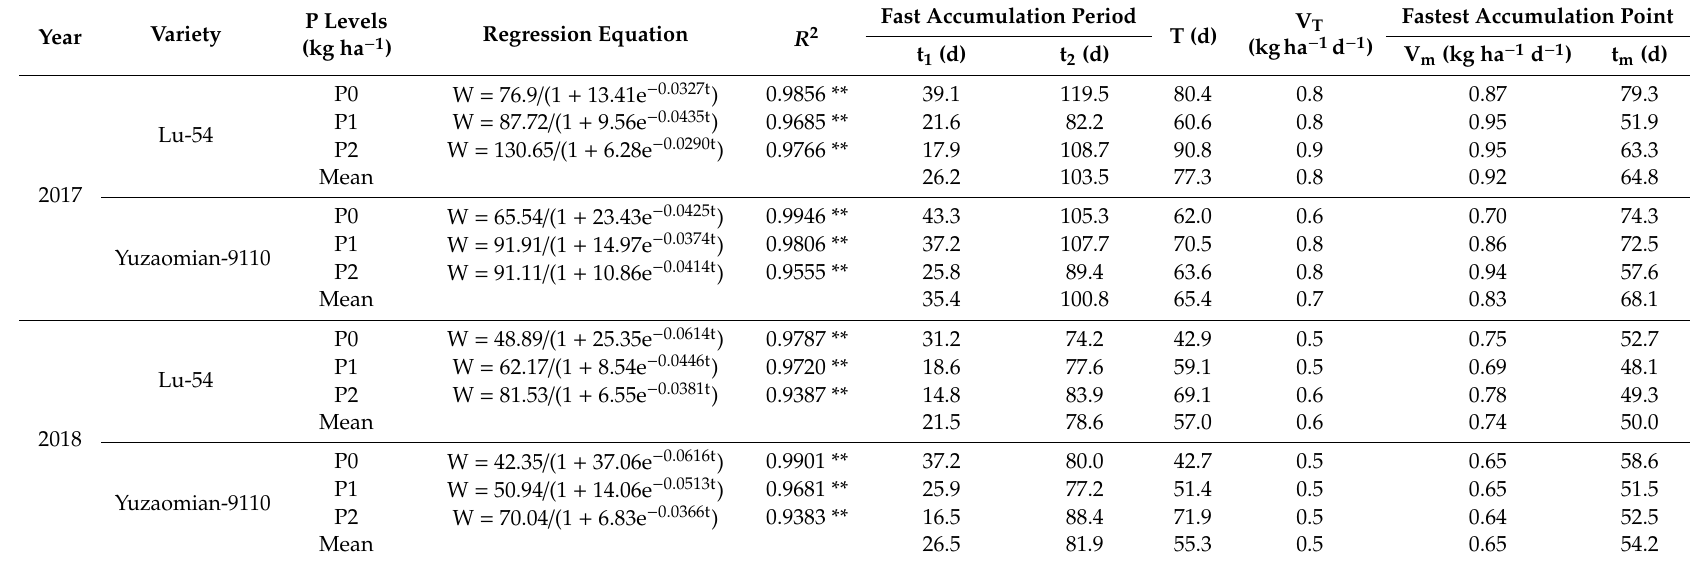
Table 2. Dynamic models and the maximum accumulation rate of N (V M ), average speed of N accumulation (V T ), start time of the N rapid-accumulation period (t 1 ), termination time of the N rapid-accumulation period (t 2 ), duration of the N rapid-accumulation period (T), and occurrence time of maximum accumulation rate of N (t m ) in reproductive organ of cotton plants for Lu-54 and Yuzaomian-9110 in 2017 and